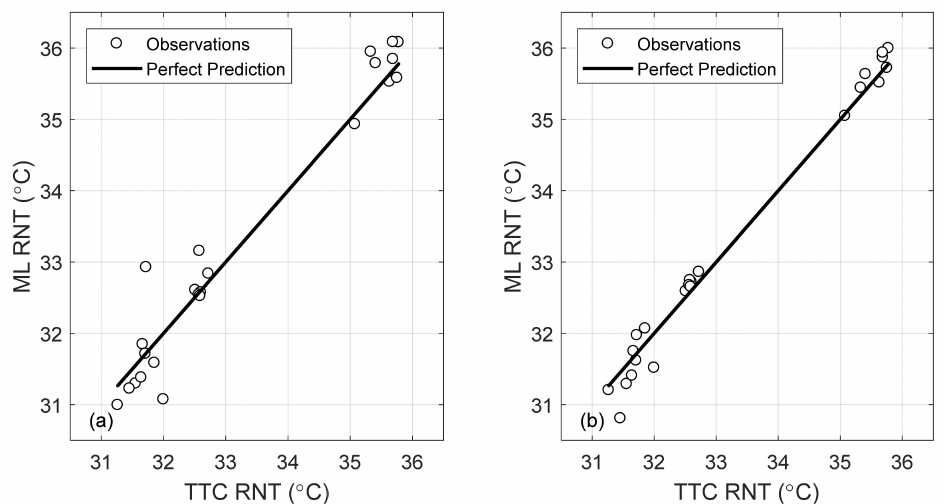
Figure 22. Testing the D12 on empirical data. Predicted RNT vs. Actual RNT for: ( a ) F1 through F6 Input; ( b ) F5 and F6